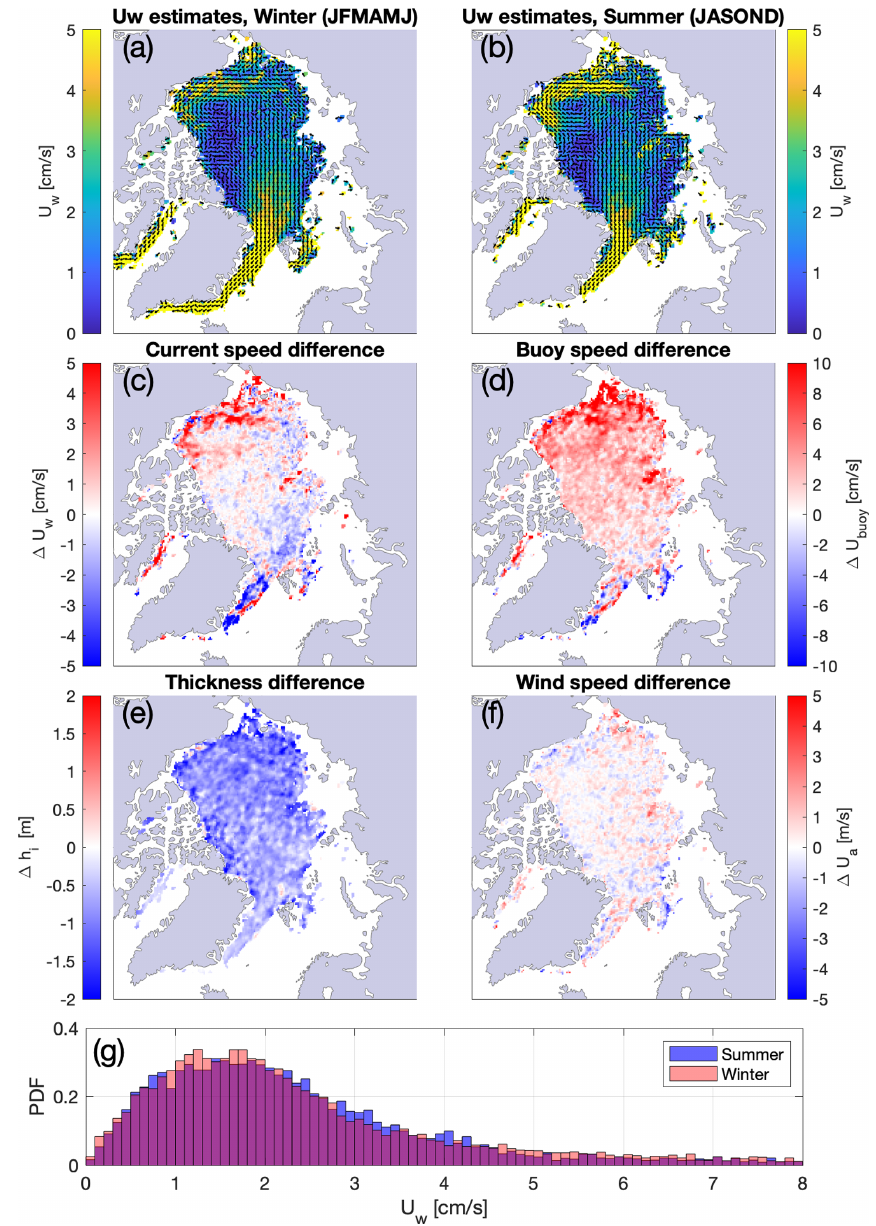
Figure 10. Estimates of the oceanic surface currents for (a) the summer season (JASOND) and (b) the winter season (JFMAMJ). Maps of the difference (summer minus winter) are presented for the following fields: (c) surface oceanic currents speed, (d) buoy-derived ice drift speed, (e) ice thickness from PIOMAS, and (f) 10m wind speed from ERA5. The distribution of current speed for the summer/winter seasons is presented in panel (g)